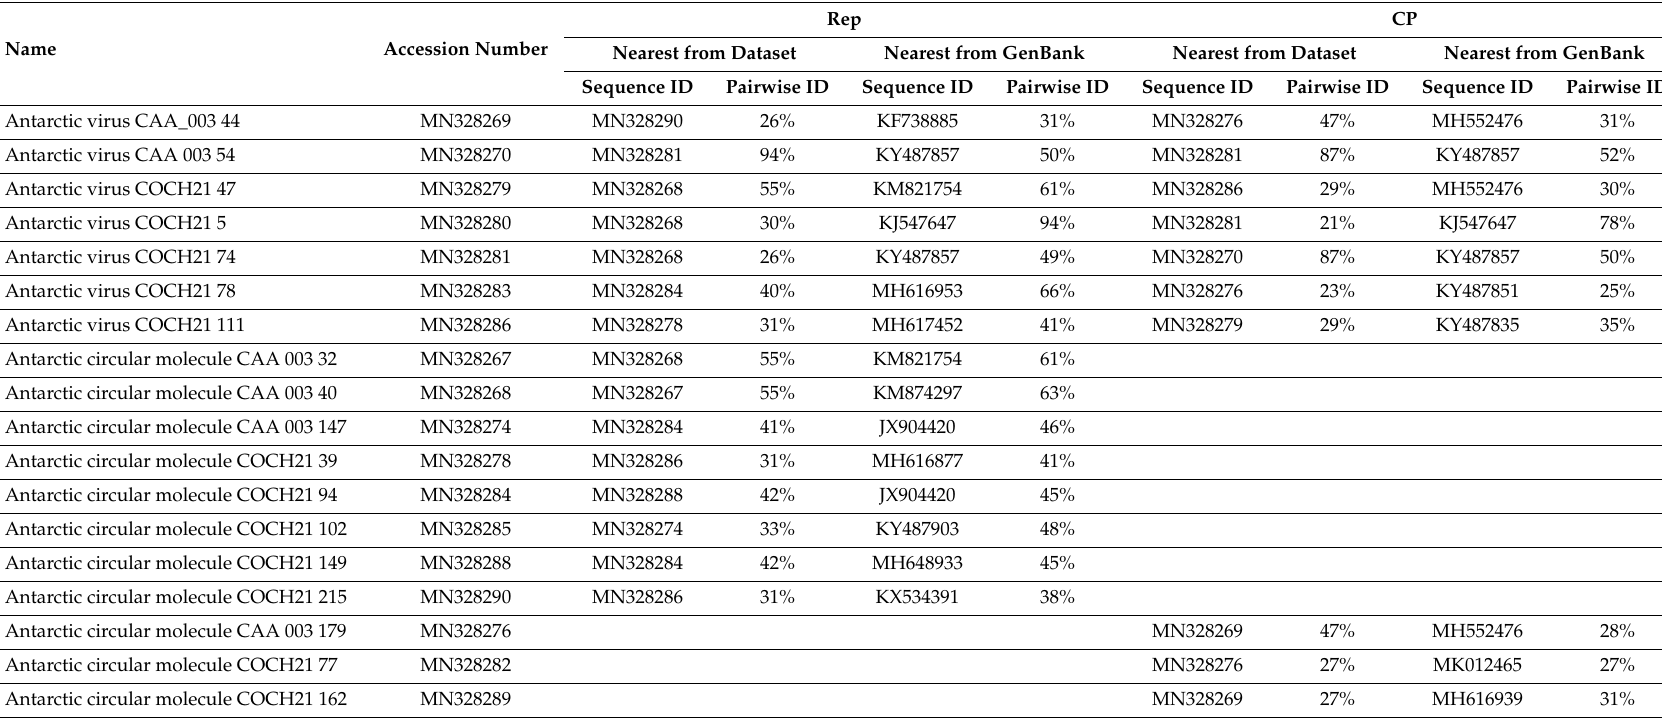
Table 3. Pairwise amino acid sequence identities of the Reps and capsid proteins (CPs) encoded by viruses and circular molecules identified in this study with each nearest match within this dataset, and those of viral sequences in GenBank. The pairwise identities were determined using SDT v1.2